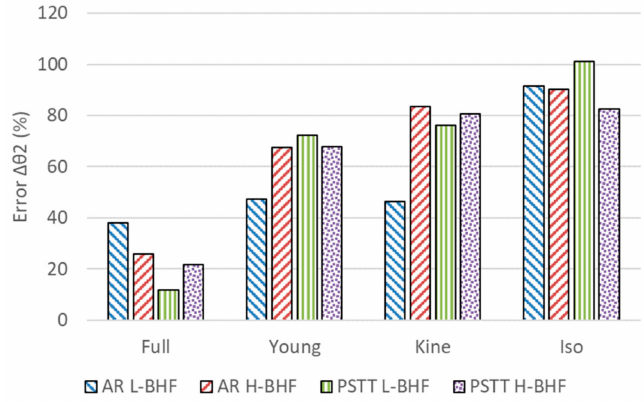
Figure 15. Accuracy of the di ff erent models in terms of the ∆ θ 2 springback